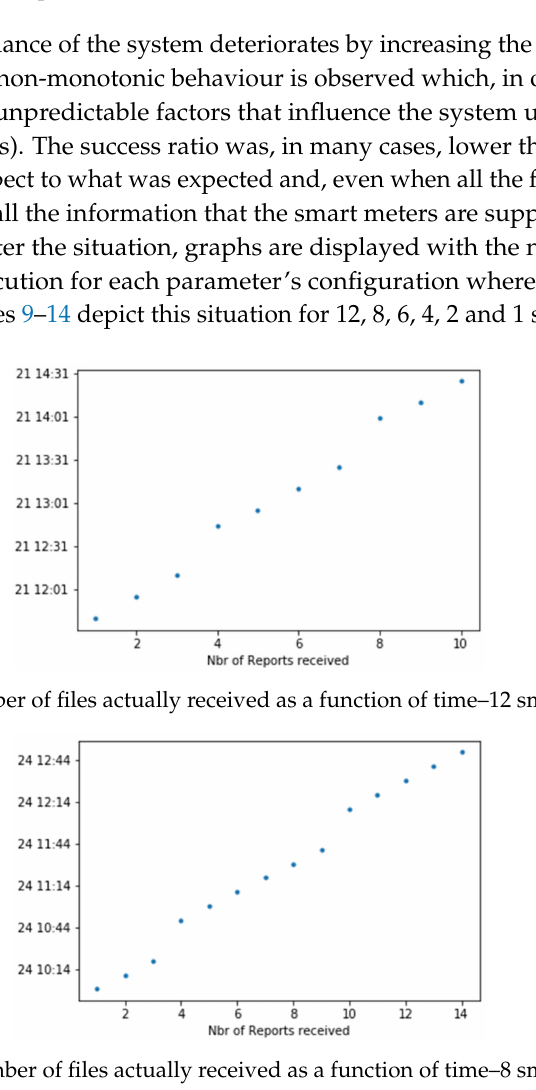
Figure 8. Success ratio in terms of smart meters’ readings received by the data concentrator as a function of the two analysed parameters.